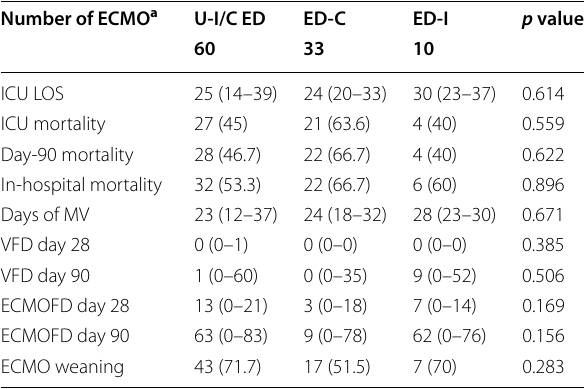
Table 2 Outcome of extracorporeal membrane oxygena- tion in patients without infected/colonised ECMO device, with ECMO device colonisation and ECMO device infection (at the time of ECMO removal) Number of ECMO